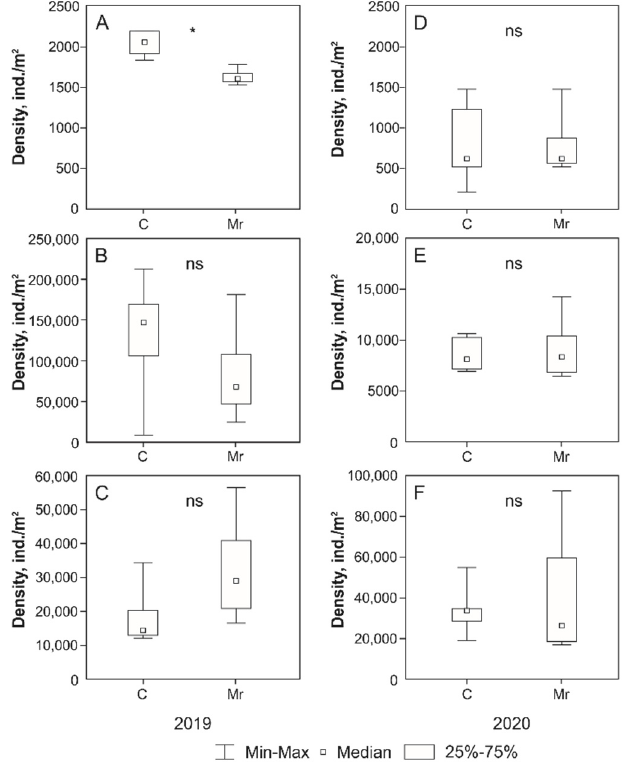
Figure 1. For 2019 and 2020. ( A , D )—June; ( B , E )—July; ( C , F )—August. Mann–Whitney test: *—differences are significant ( p < 0.05), ns—non-significant differences ( p > 0.05). Table 2. Results of comparative analysis of the density of soil microarthropods (ind./m 2 ) in the plots with different types of seed treatment in 2019 (Mann–Whitney test).